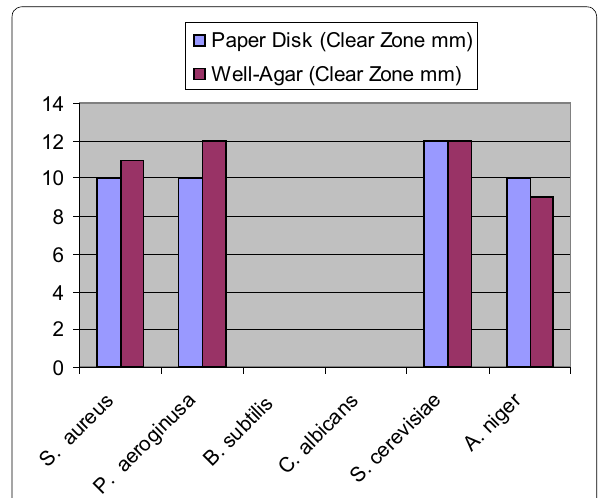
Fig. 5 Antimicrobial activity of compound 8 using agar disk diffusion